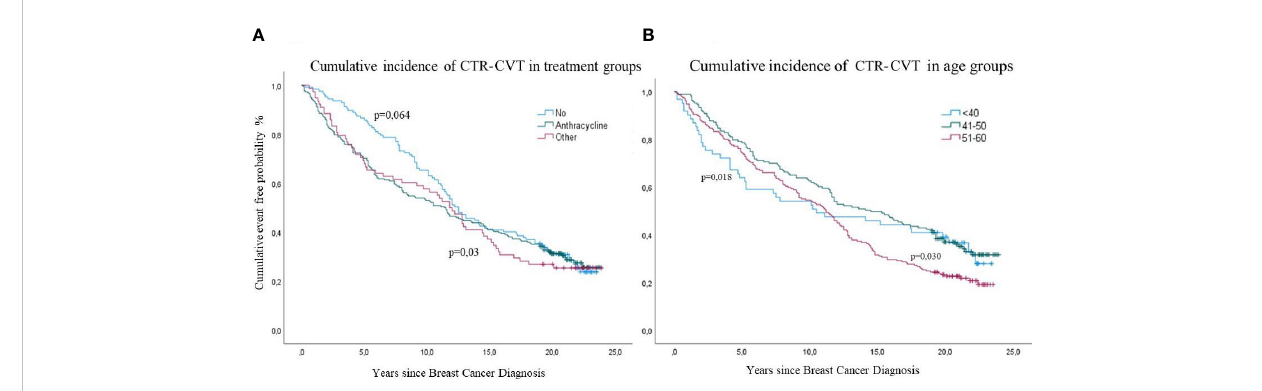
FIGURE 5 Cumulative incidence of cancer therapy-related cardiovascular toxicity (CTR-CVT) after breast cancer (BC) by years since diagnosis, with death as a competing risk, in 433 patients with lymph node-positive early breast cancer at diagnosis in the Southeast Healthcare Region, Sweden, January 1, 1998, to December 31, 2002. (A) (Left panel): Cumulative incidence of four CTR-CVT events by treatment group, analyzed with Log Rank (p=0,03) for all, and Breslow (p=0,06) for the no Chemo group. (B) (Right panel): Cumulative incidence of CTR-CVT by age group, analyzed with Log Rank (p=0,018) for all age groups and Tarone-Ware (p=0,030) for the latest